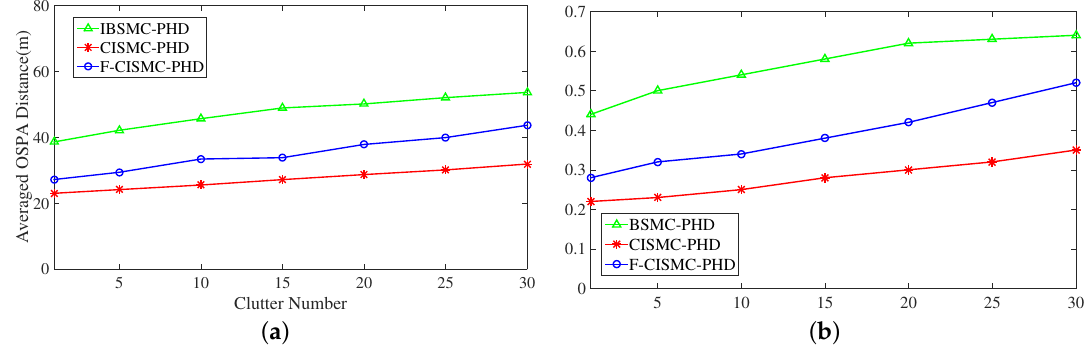
Figure 6. Estimated error of the IBSMC-PHD, CISMC-PHD and F-CISMC-PHD approaches along with the clutter number changing from 1 to 30. ( a ) Averaged OSPA distances; ( b ) Averaged RMSEs of estimated